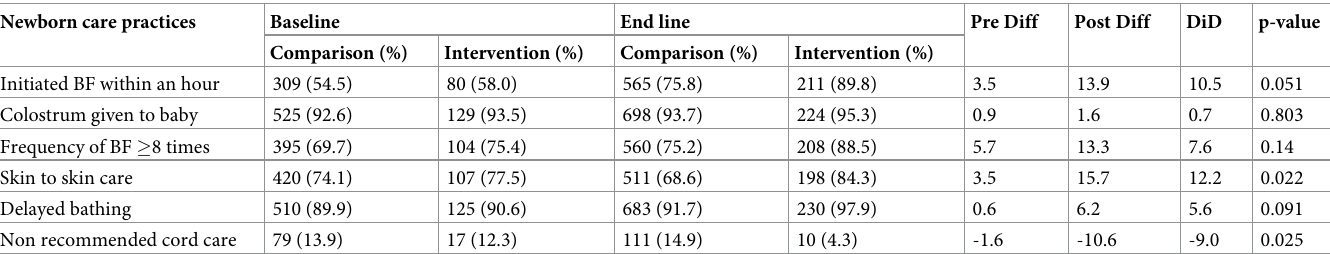
Table 6. Effect of the intervention on newborn care practices. Newborn care